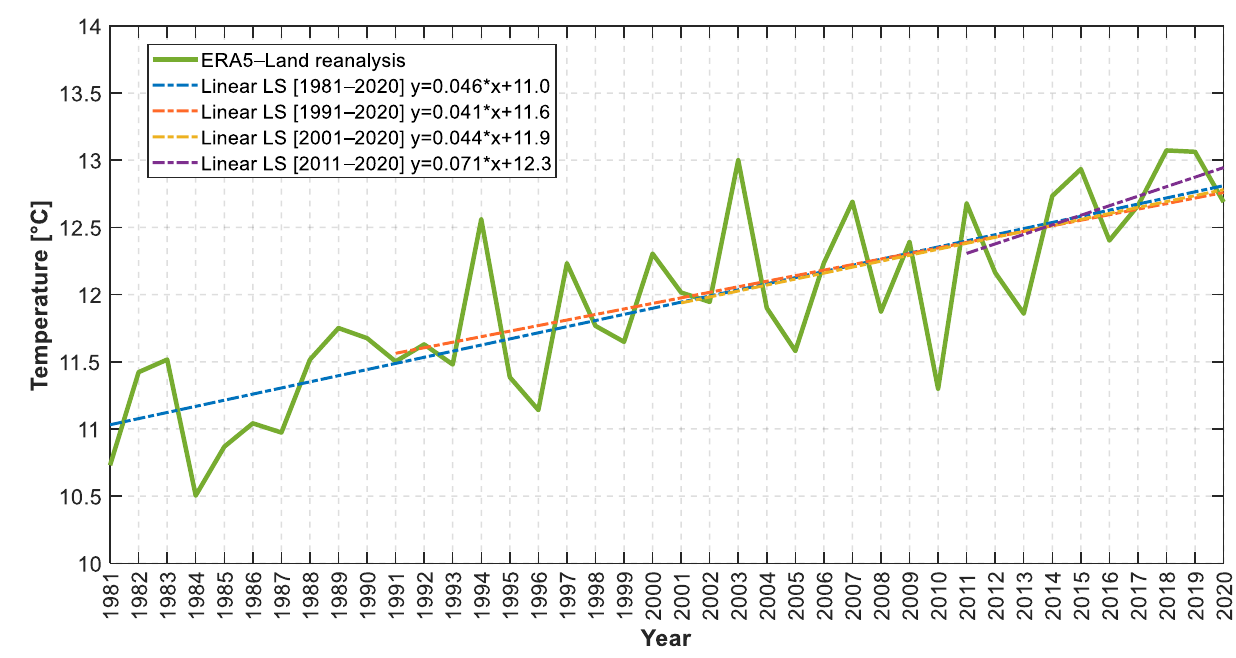
Figure 8. Reconstruction of mean annual temperature (1981–2020) by the ERA5-Land reanalysis over the section of the Seveso River basin closed at Bovisio-Masciago.